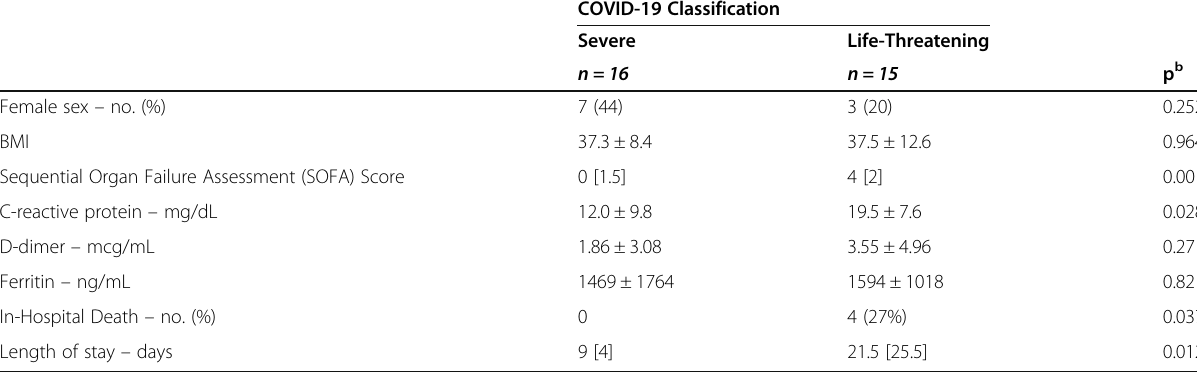
Table 2 Characteristics of patients with severe vs. life-threatening disease receiving COVID-19 convalescent plasma at time of